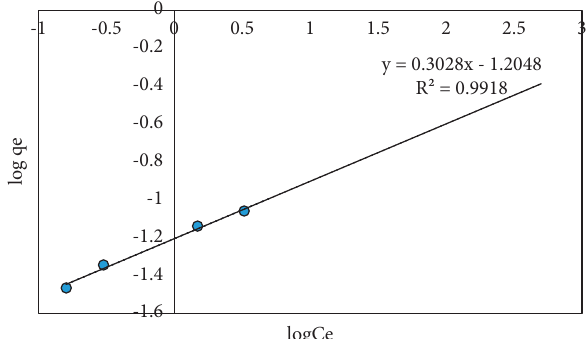
Figure 7: Freundlich isotherms for the as-produced MWCNTs-Fe